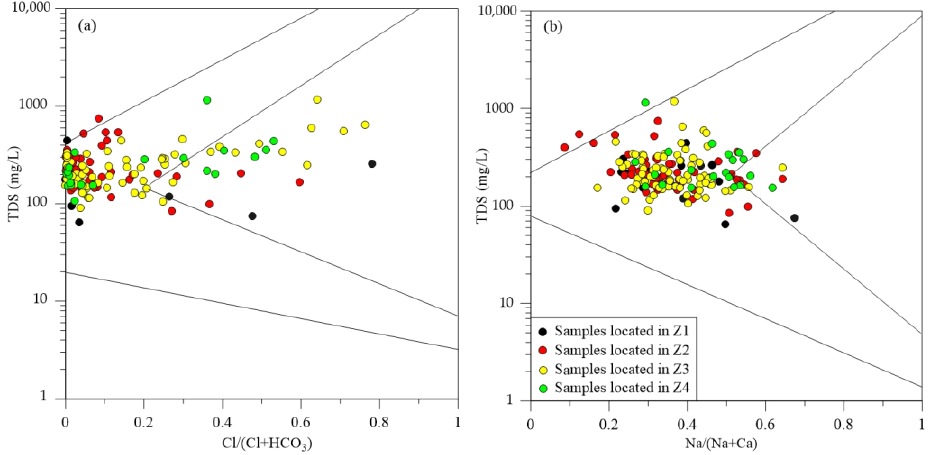
Figure 4. Gibbs plot of water samples in MXP: total dissolved solids (TDS) as a function of weight ratios of ( a ) (Cl/Cl+HCO 3 ) and ( b ) Na/(Na+Ca).